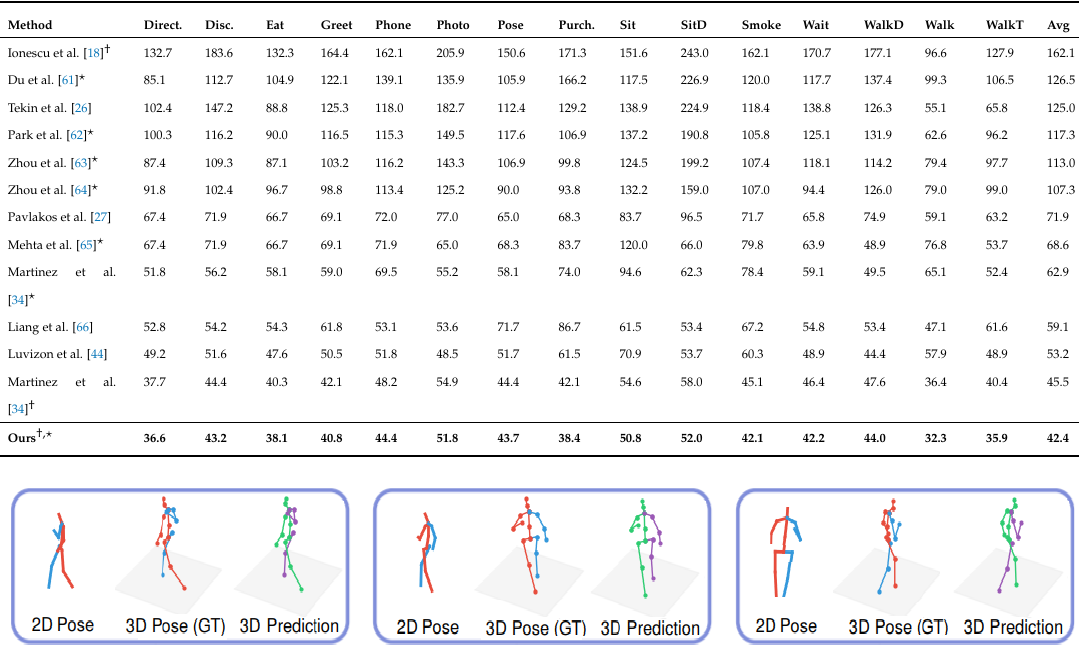
Figure 7. Visualization of 3D output of the estimation stage with some samples on the test set of Human3.6M [18]. For each example, from left to right are 2D poses, 3D ground truths and the 3D predictions,